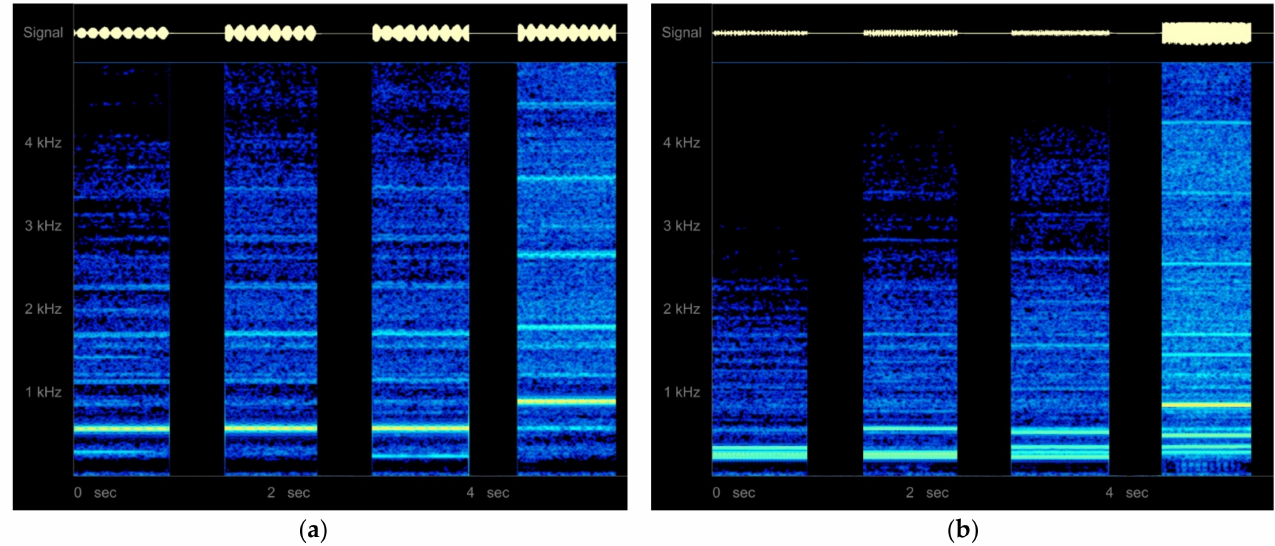
Figure 28. Spectrograms of quadruple flute experimental model “Zacuala Palace”, all fingerholes stopped: ( a ) diagonal playing position to the right, different blowing pressures (1–3 gradually increasing, 4 overblown); ( b ) diagonal playing position to the left, different blowing pressures (1–3 gradually increasing, 4 overblown) (Sample S13).